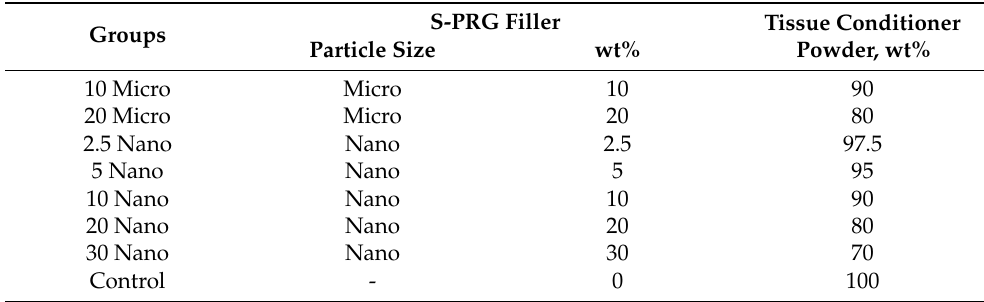
Table 2. Composition of tissue conditioner samples in the experimental and control groups (with and without S-PRG filler,